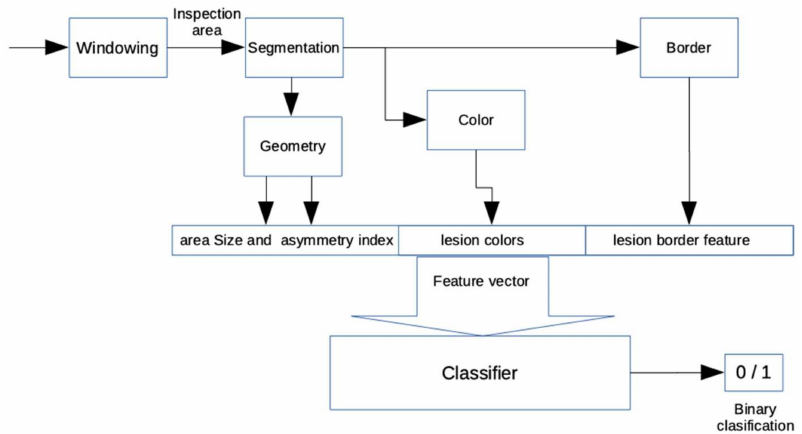
Figure 1. Block diagram of the conceived CAD